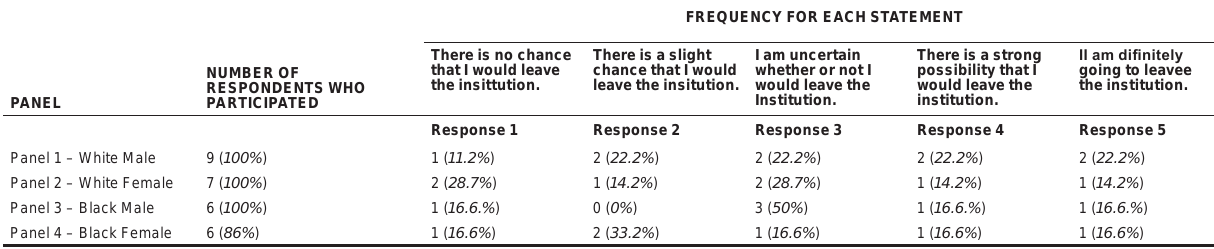
table 3 Intentions to quit after round two of the study